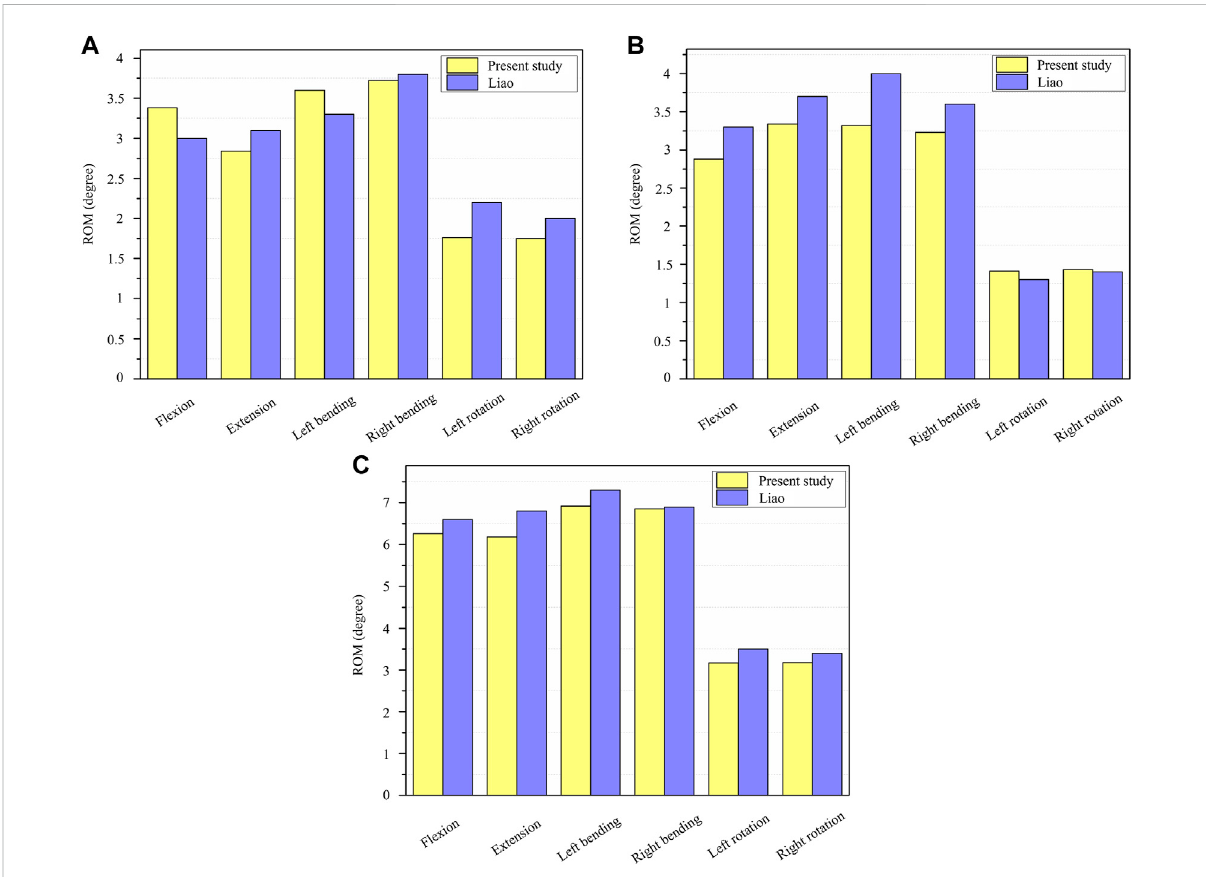
FIGURE 4 Validation oftheT11-L1 thoracolumbar vertebral model. (A) TheROM ofT11-T12undersix loadingconditions; (B) The ROM ofT12-L1 under six loading conditions; (C) The ROM of T11-L1 under six loading